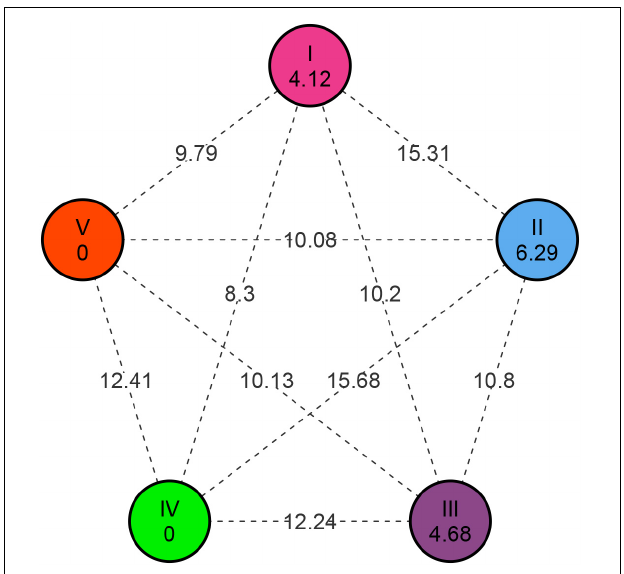
flowering, days to 100% flowering, plant height at flowering initiation, plant height up to the first primary branch, seed size, and seed yield/plant. The very high heritability of seed yield per plant (63%) in pooled analysis with a high GA of 60.8% indicated that the results would be repeatable and rewarding over generations of selection cycles, which is a boost for the breeding program. This concurred with previous studies (Kumar and Misra, 2007; Yadava et al., 2011; Tripathi et al., 2013; Meena et al., 2017; Kumar et al., 2019). These results indicate a greater scope for selection to improve seed yield per se in the Brassica breeding program (Tiwari et al.,